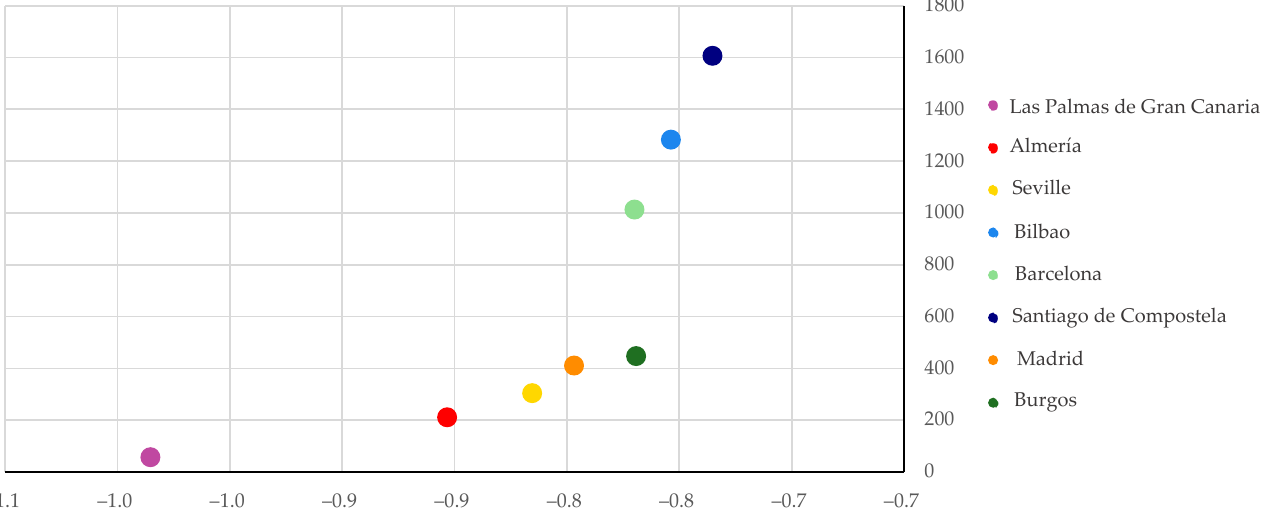
Figure 5. Heat losses due to evapotranspiration (W/m 2 ) in the extensive green roof of model B regarding annual rainfall (mm) in each of the 8 cities.